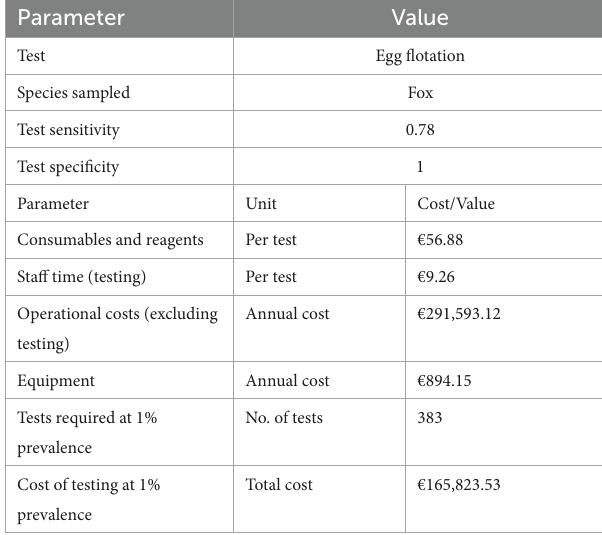
TABLE 1 Hypothetical data showing the cost breakdown per test of the egg flotation test, and the data sources associated with these